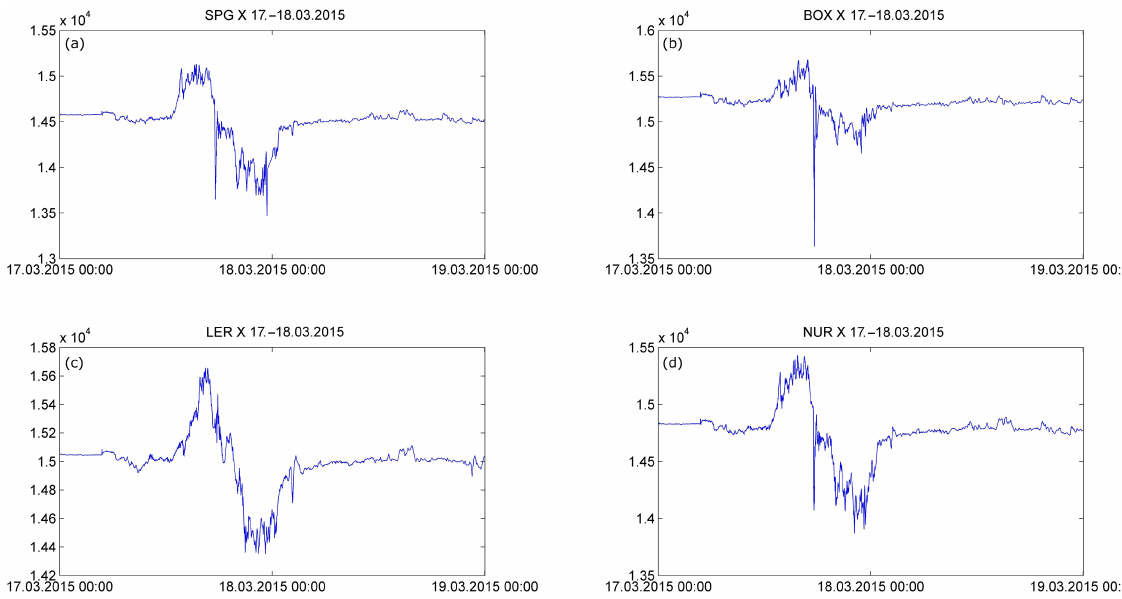
Figure 5. Minute magnetic variations of the X component during the strong magnetic storm of 17–18 March 2015.